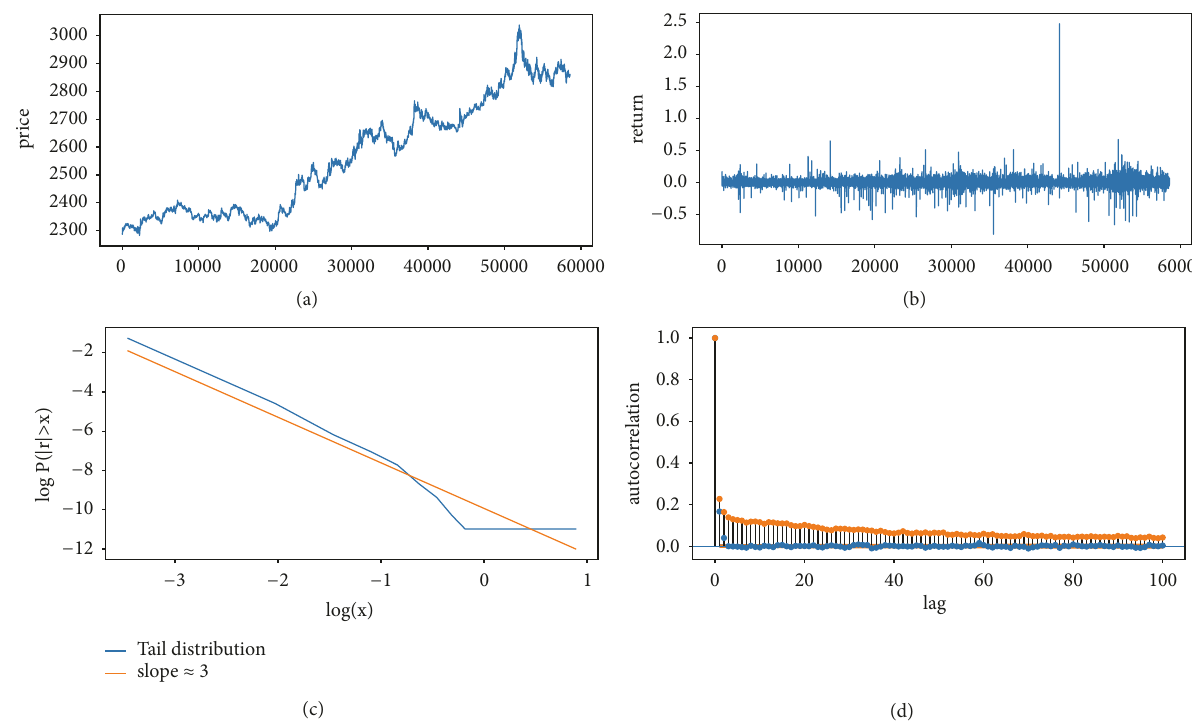
Figure 1: The empirical analysis of the SSE 50 Index's 1-minute price series . (a) 1-minute price series; (b) return series that eliminates the overnight effect (in percentage); (c) tail distribution of the absolute return in the log-log scale and a least-square fit for values with a slope of three; (d) autocorrelation function of return and absolute return, where the autocorrelation function of absolute return decays slowly, indicating that the volatility has long-memory characteristics.